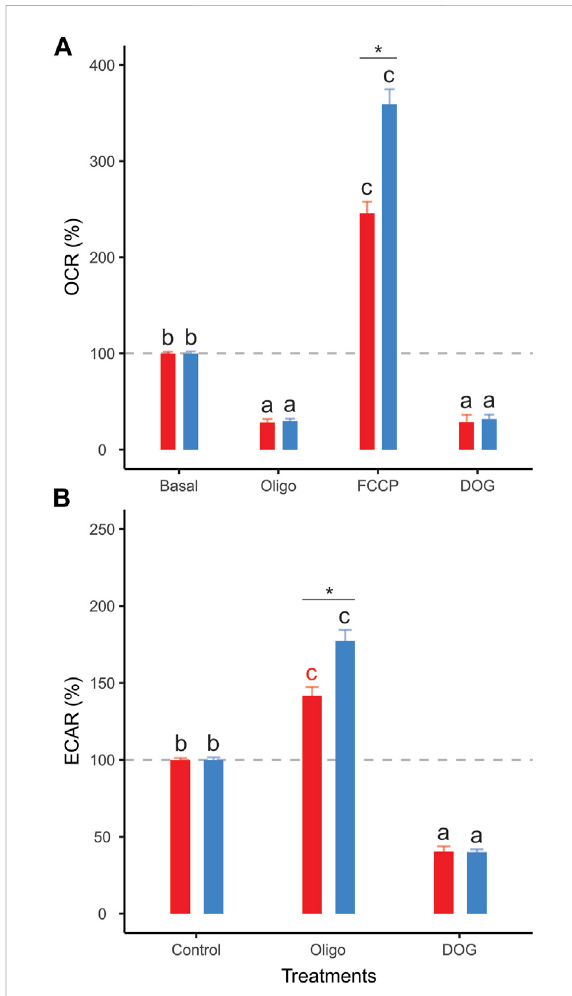
FIGURE 4 Effect of metabolic modulators on mouse sperm OCR (A) , ECAR (B) expressed as percentages relative to the basal state. Sperm were incubated in non-capacitating (red bars) and capacitating (blue bars) conditions prior to extracellular fl ux analysis. Bars correspond to means +standard error. Treatments represent sperm metabolic rates before any addition (Basal) or after the addition of 5 µM oligomycin (Oligo); 1 µM FCCP (FCCP); 50 mM2DOG (DOG);or1 µMantimycinA+1 µMrotenone(A+R). Dashed grey lines indicate 100% level. Different letters indicate signi fi cant differences ( p < 0.05) between treatments for the same incubation condition in a post-hoc marginal means test. Asterisks indicate signi fi cant differences ( p < 0.05) between incubation conditions for the same treatment in a post-hoc marginal means